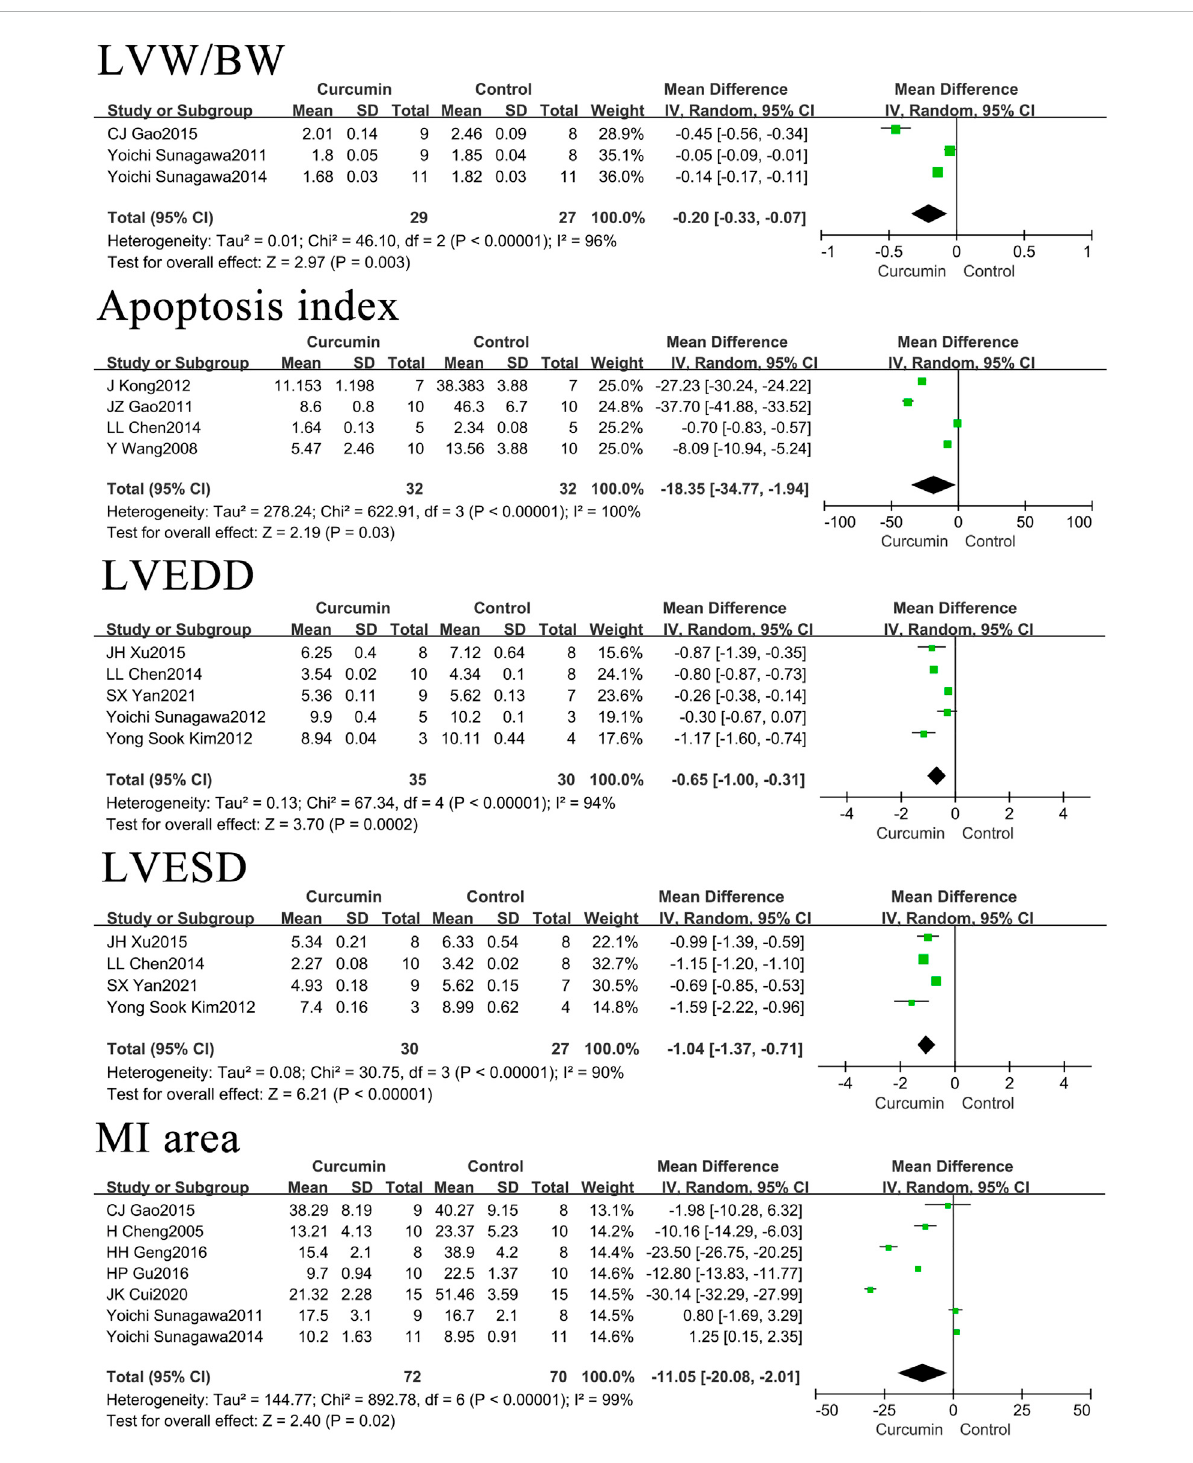
Forest plot of cardiac tissue structure related indicators: LVW/BW, Apoptosis index, LVEDD, LVESD, MI